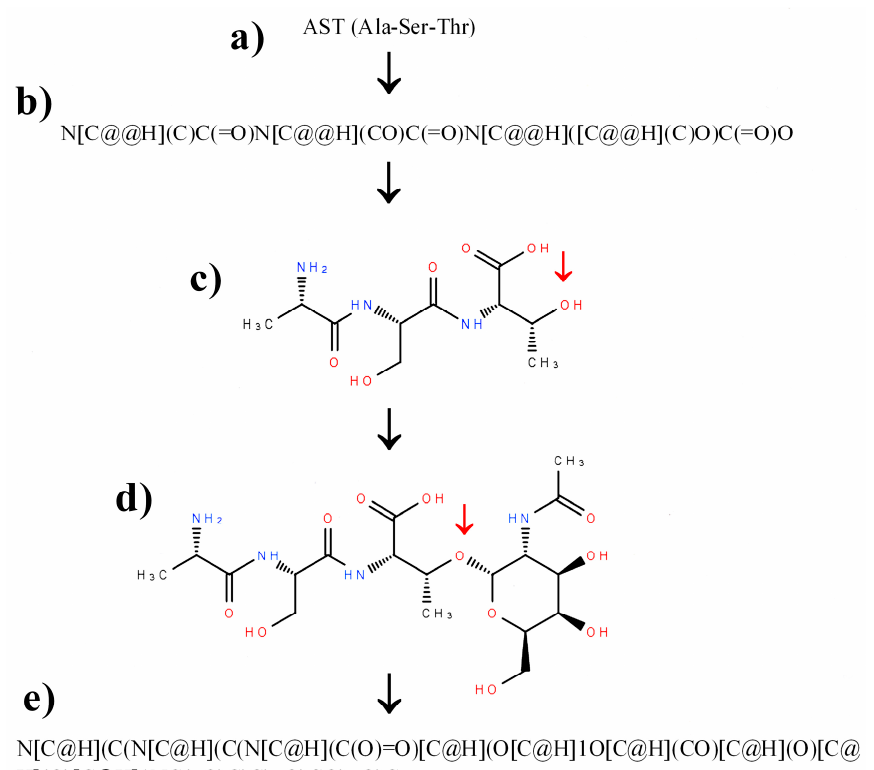
Figure 3. Scheme illustrating construction of SMILES representation of a modified peptide AST (Ala-Ser-Thr): ( a ) peptide sequence; ( b ) SMILES representation of unmodified peptide, constructed in agreement with scheme presented in Figure 2; ( c ) structure of unmodified peptide, displayed using program Ketcher (v. 2.0); and, ( d ) structure of peptide with a glycosylated threonine residue in position 3 (added residue of N -Acetyl- α - D -galactosamine–PubChem CID 84265); ( e ) SMILES representation of glycosylated peptide. Red arrows indicate modification site in structures of peptide and glycopeptide.